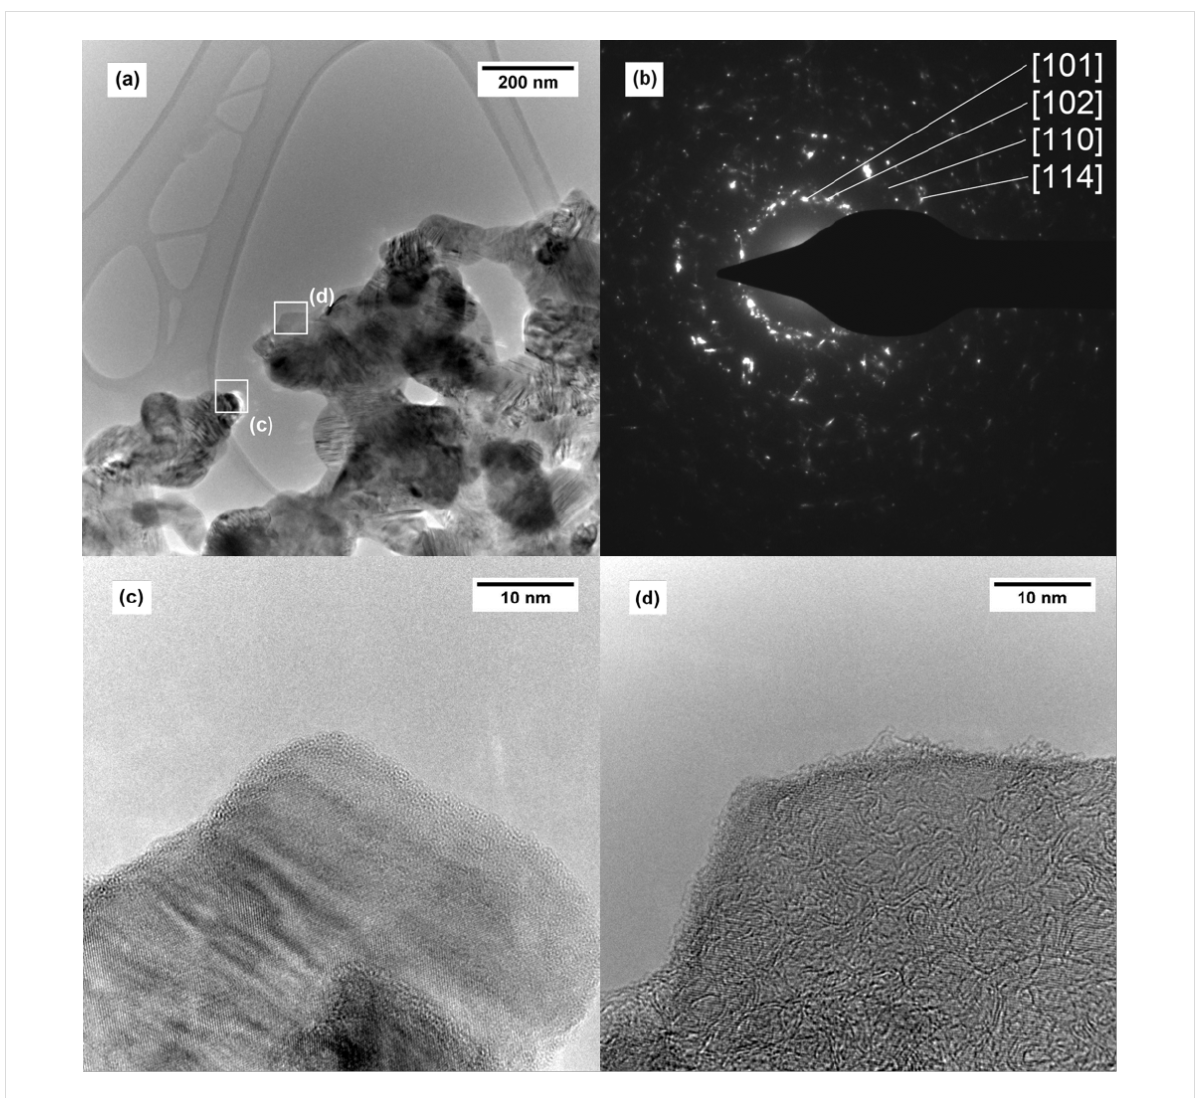
Figure 7: TEM images of a SiC tube wall with interconnected, crystalline SiC particles (a) and the corresponding SAED pattern (b). Individual SiC crystallites are shown in (c) and the SiC surface with a layer of microcrystalline carbon on the SiC surface is shown in (d).